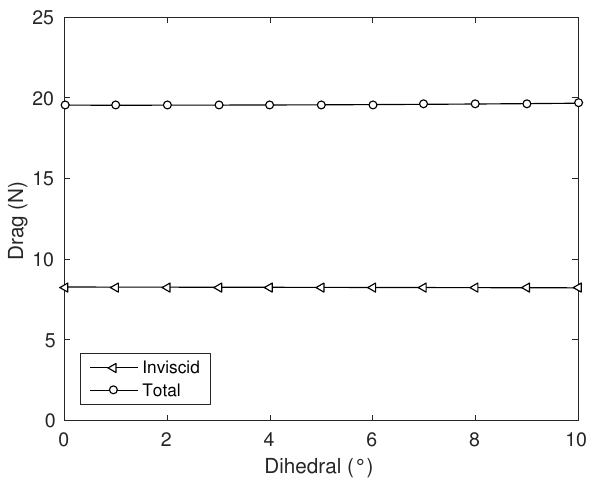
Figure 18. Sensitivity study: dihedral